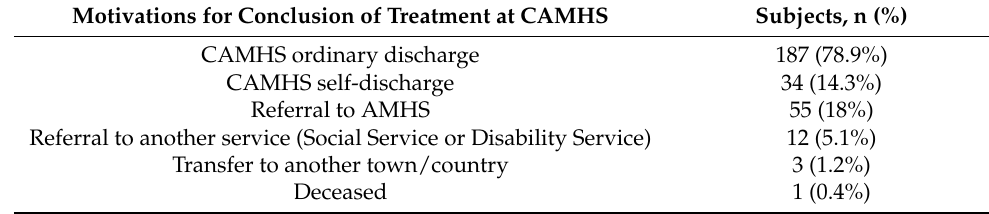
Figure 1. Adult follow-up of ADHD individuals treated at CAMHS in Modena from 1995 to 2015. Table 1. Follow-up of minors in care at CAMHS from 1995 to 2015 for ADHD (n = 303). Motivations for Conclusion of Treatment at